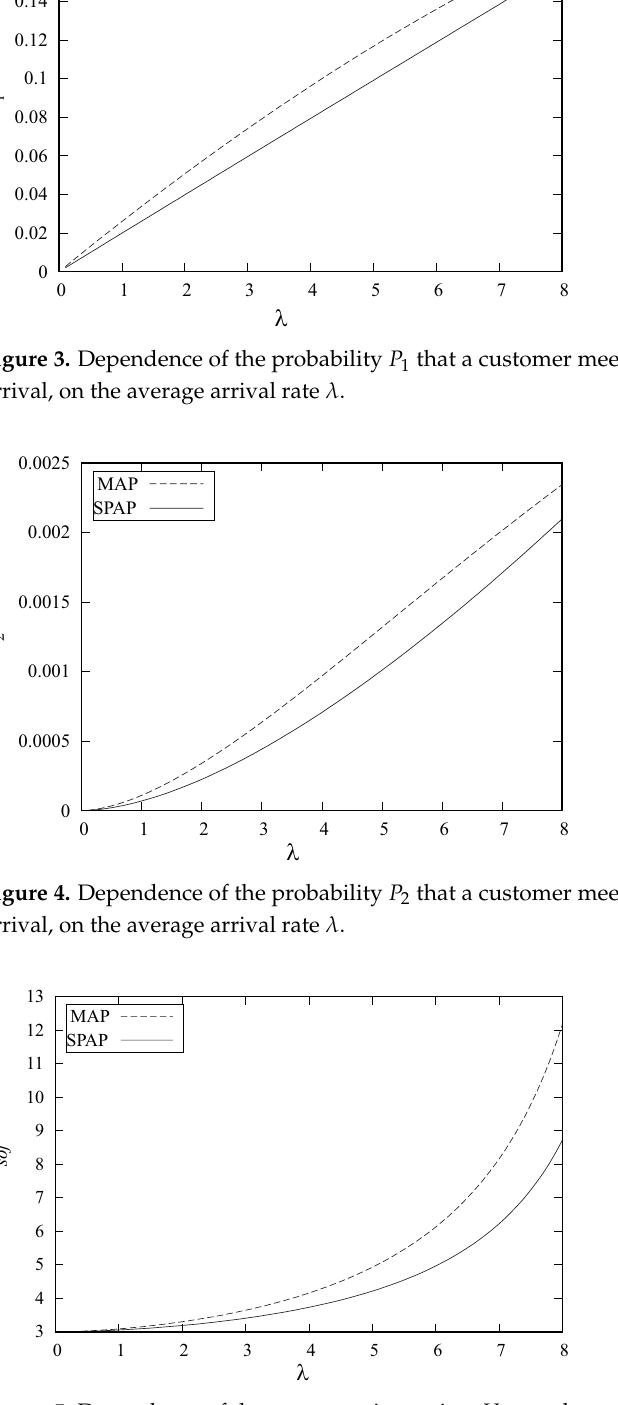
Figure 5. Dependence of the average sojourn time V soj on the average arrival rate λ